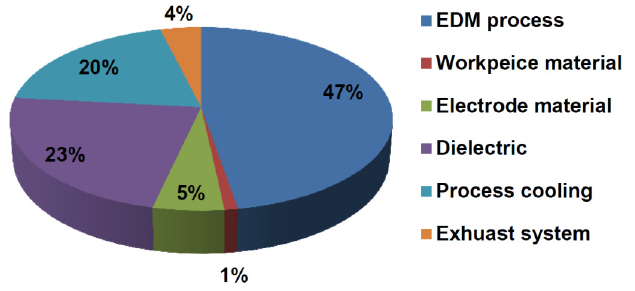
Figure 2. The percentage of energy consumptions in WEDM process [28,29].